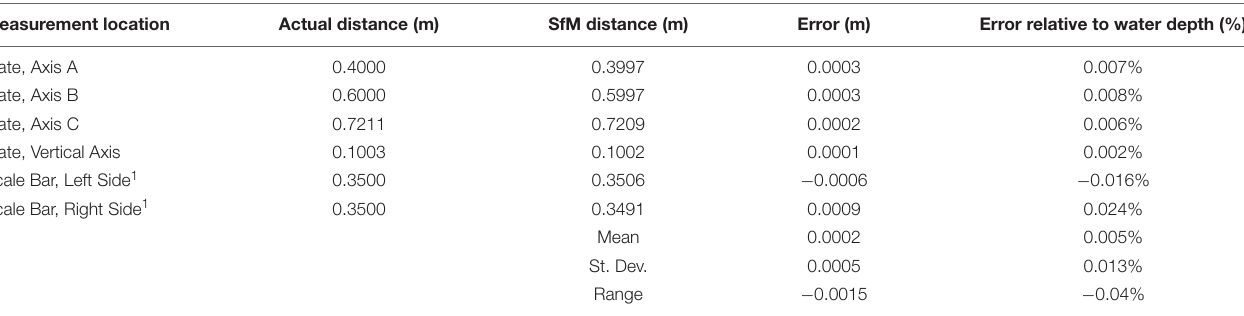
TABLE 3 | Comparisons of SfM distance measurements using no ground control with machined scales placed on the seafloor. Measurement